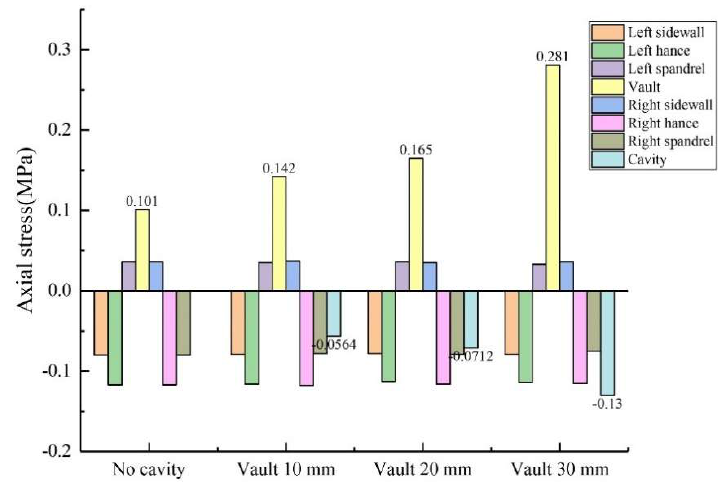
Figure 13. Variation of axial stress with vault void depth.